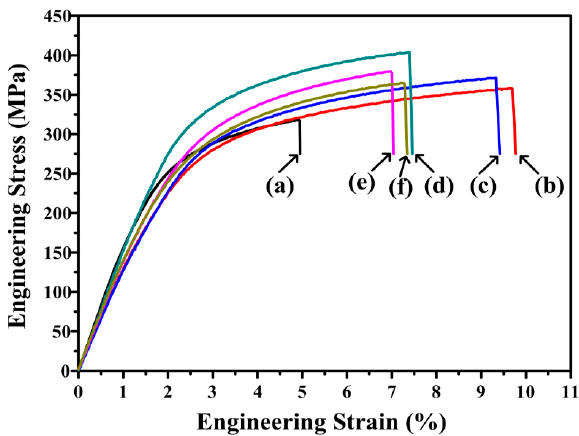
Figure 7. Tensile engineering stress–strain curves of: ( a ) extruded AT81 and 0.5 vol % n-SiC p /AT81 composites reinforced by n-SiC p with different pre-oxidation parameters: ( b ) untreated; ( c ) 973 K/2 h, ( d ) 1073 K/2 h; ( e ) 1173 K/2 h; and ( f ) 1273 K/2 h. Table 1. Tensile properties of the extruded AT81 and 0.5 vol % n-SiC p /AT81 composites reinforced by n-SiC p with different pre-oxidation parameters.